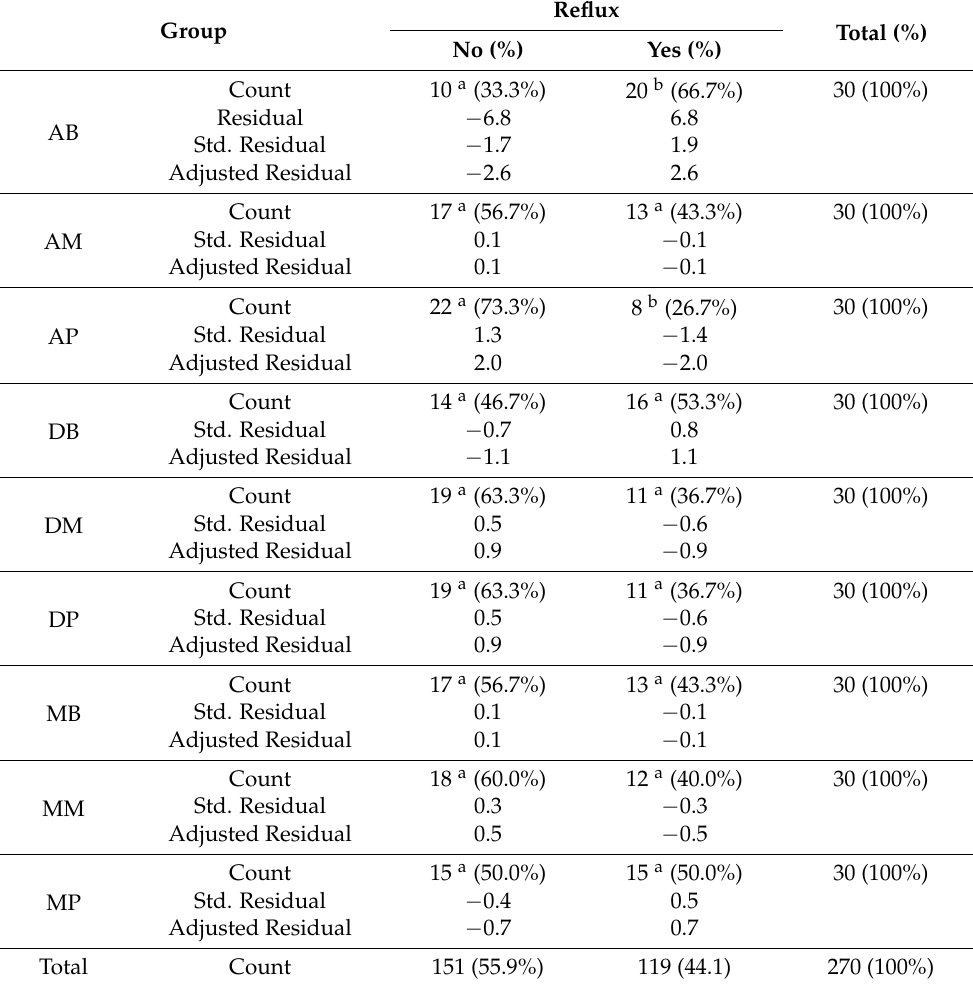
Table 4. The incidence of GOR within the premedication groups in dogs submitted to esophageal pH-measurement during anesthesia for non-intrabdominal, non-intrathoracic procedures. (n = 30 dogs in each